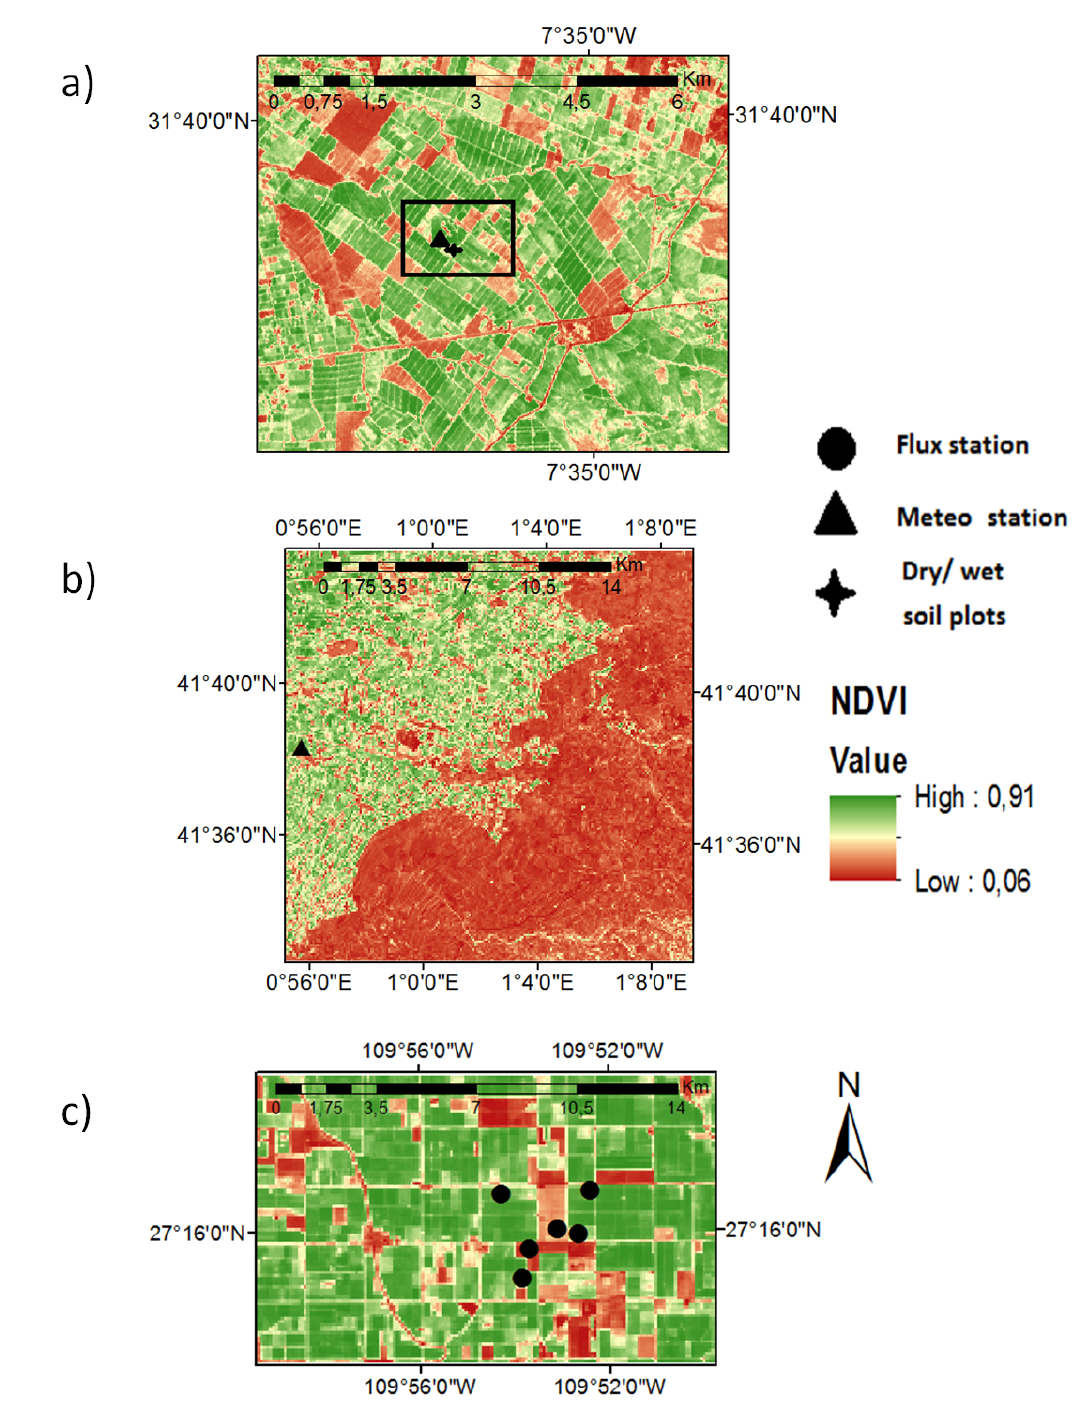
Figure 1. The three study sites included in this paper: ( a ) the R3 perimeter, ( b ) the Urgell area and ( c ) the Yaqui